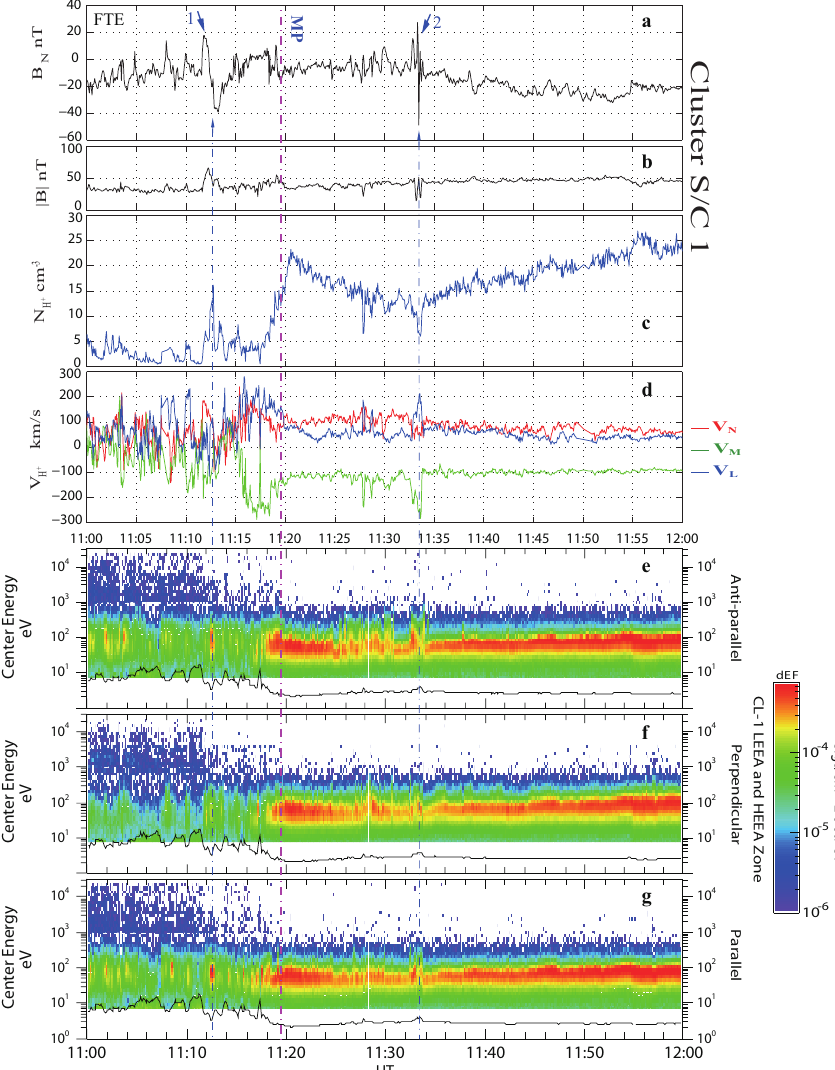
Fig. 6. Zoom in of (a) the magnetic field boundary normal component B N (same as Fig. 3c), (b) the field magnitude, (c) the number density and (d) velocity (projected into LMN coordinates) of H + from CIS instrument onboard Cluster S/C 1, together with PEACE electron spectrograms in the (e) anti-parallel, (f) perpendicular, and (g) parallel directions, observed by Cluster S/C 1.